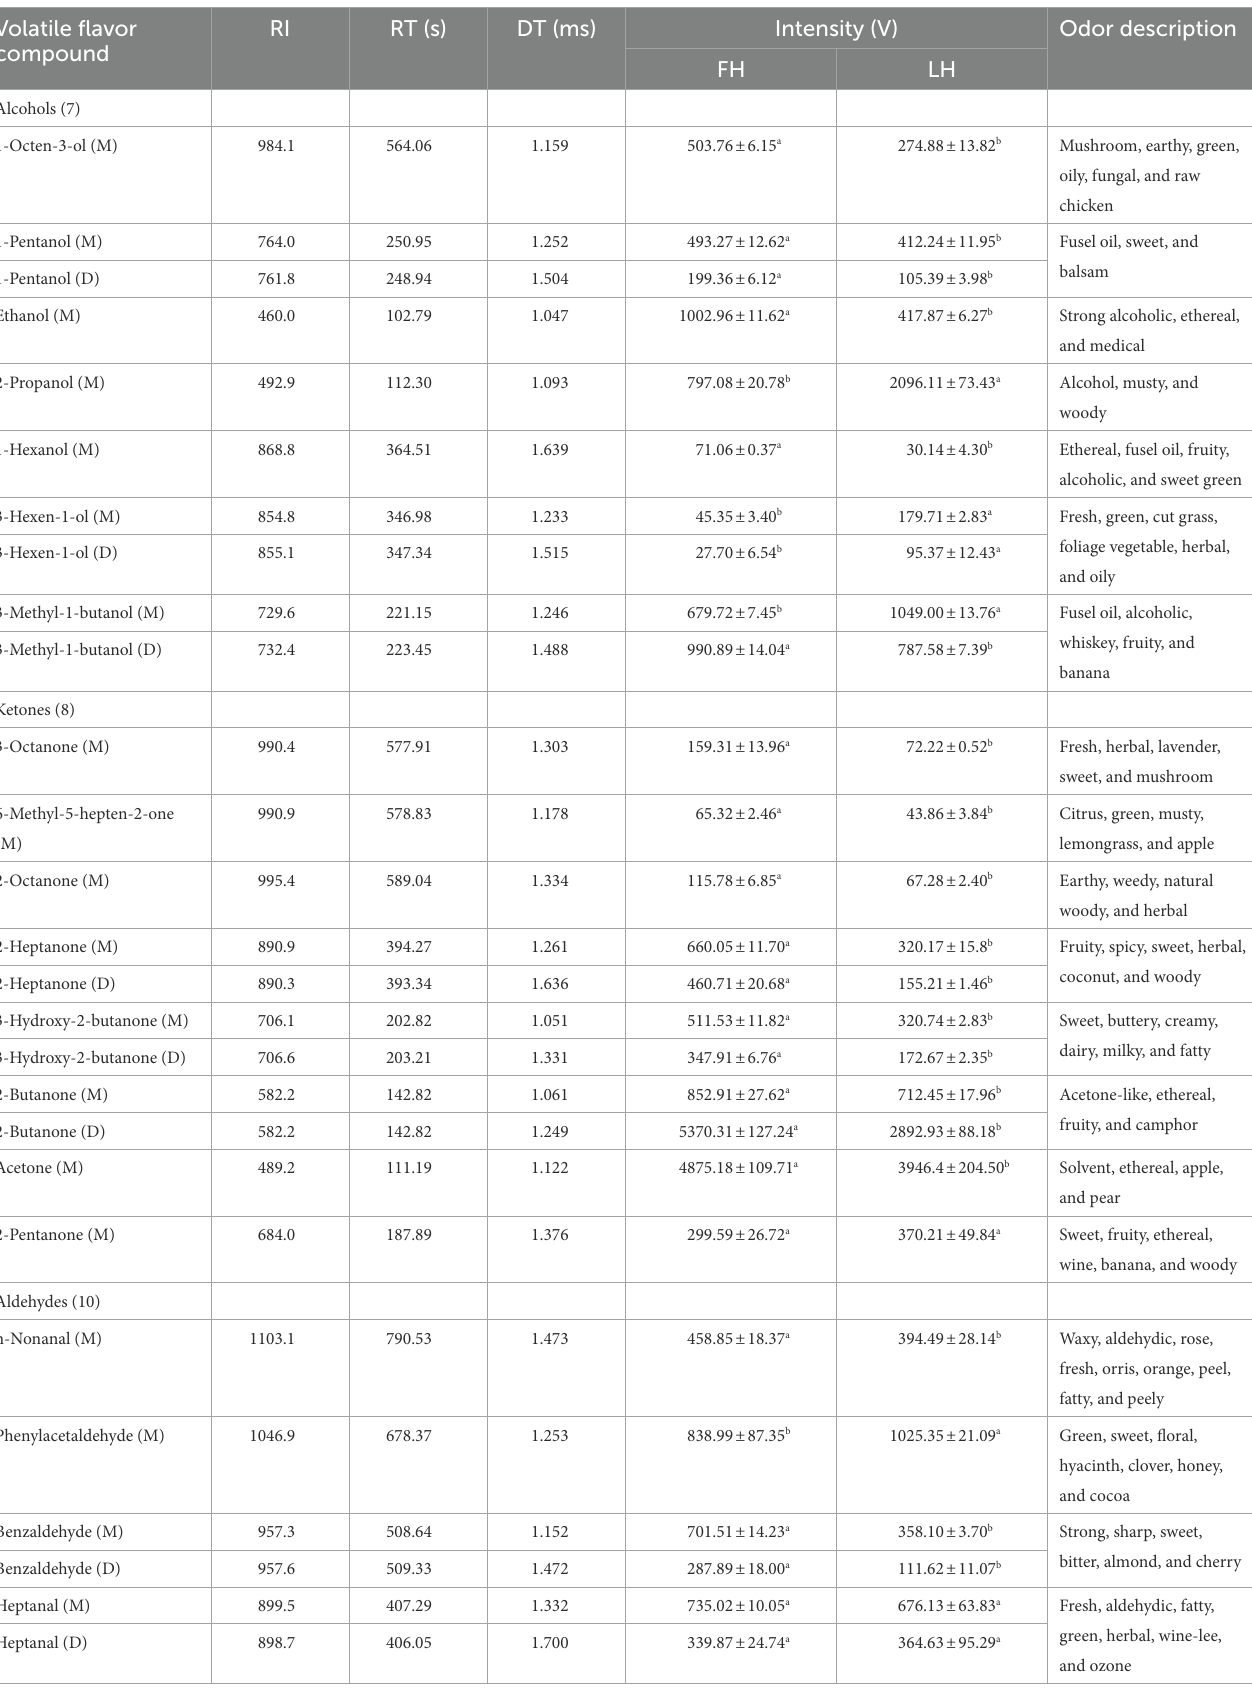
TABLE 2 Intensities of 33 identified volatile flavor compounds from Jinhua FH and LH by HS-GC-IMS. Volatile flavor